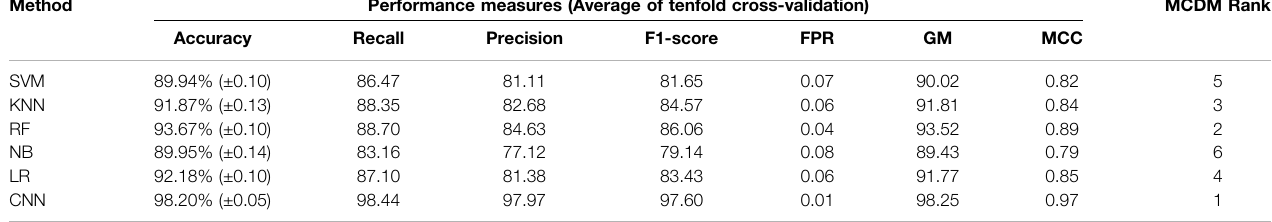
TABLE 5 | Models performance and ranking for integrated data. Method